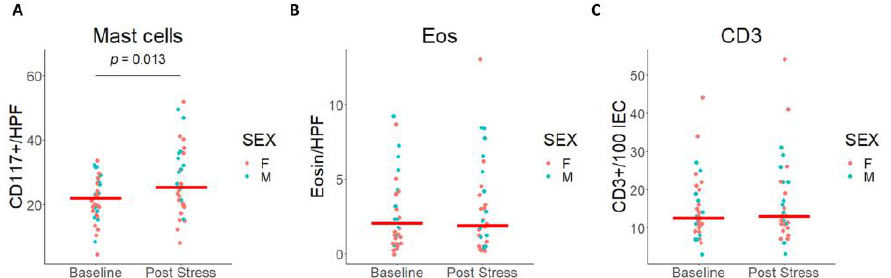
Figure 6. Mucosal inflammation in jejunal mucosa after CPS. ( A ) Mast cell counts before (Baseline) and after stress (Post Stress) expressed per HPF (400×). A two-way ANOVA revealed differences by stress, but not for sex. The red line indicates the median. * Indicates p value = 0.013. ( B ) Eosinophil counts before (Baseline) and after stress (Post Stress) expressed per HPF. ( C ) Intraepithelial lymphocyte counts before (Baseline) and after stress (Post Stress) expressed per 100 intestinal epithelial cells. CD117: cluster of differentiation 117; HPF: high-power field; Eosin: eosinophils;